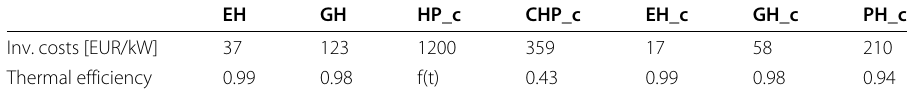
Table 1 Investment costs and thermal efficiencies for heat pumps (HP), electric heaters (EH), gas condensing heaters (GH), pellet heaters (PH), and combined heat and power units (CHP) EH GH HP_c CHP_c EH_c GH_c PH_c Inv. costs [EUR/kW] 37 123 1200 359 17 58 210 Thermal efficiency 0.99 0.98 f(t) 0.43 0.99 0.98 0.94